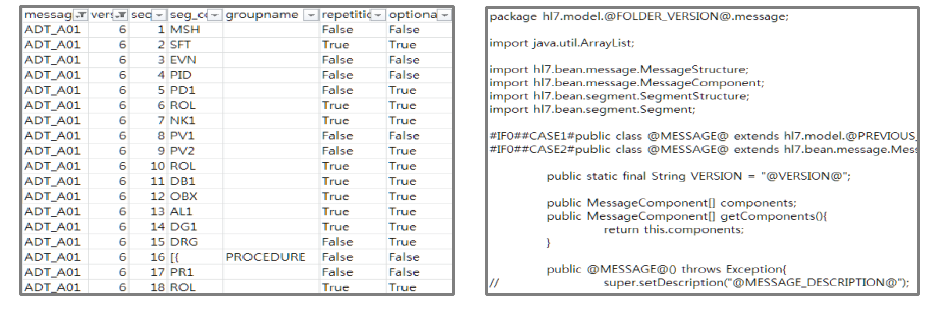
Fig. 12. Class File Maker for HL7 message